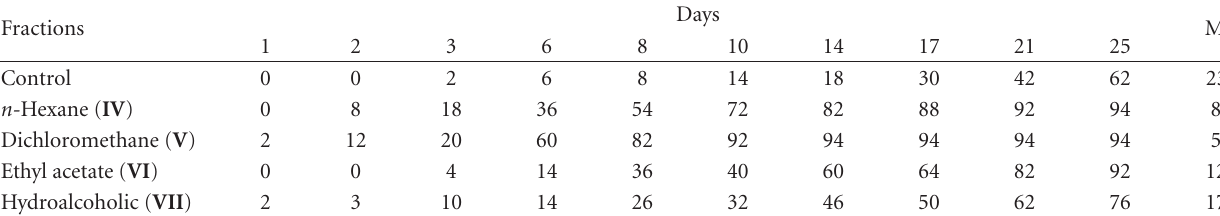
Table 2: A. sexdens rubropilosa workers mortality (%) and survival median (Md) when fed with diet containing the fractions (1000 μ g · mL − 1 ) of the methanol crude extract of leaves of V. sebifera